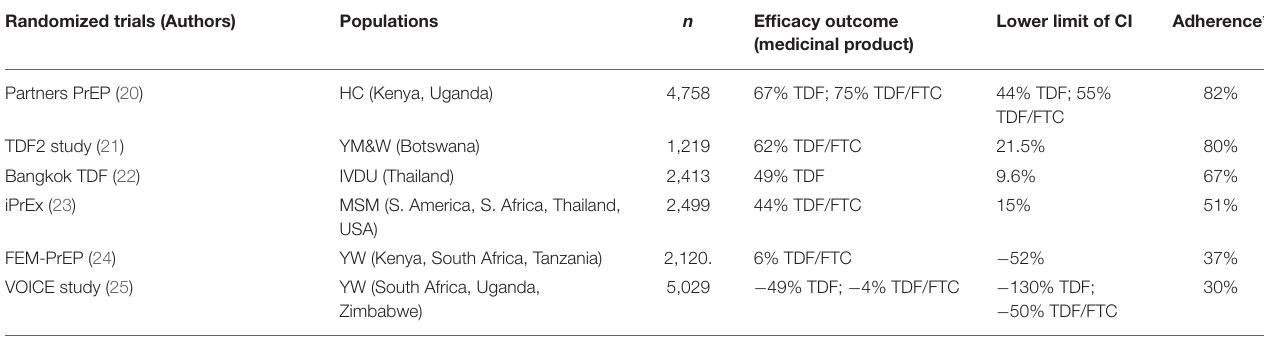
TABLE 1 | Efficacy and adherence rates across PrEP trials (Partners PrEP, TDF2 Study, Bangkok TDF, iPrEx, FEM-PrEP and VOICE). Randomized trials